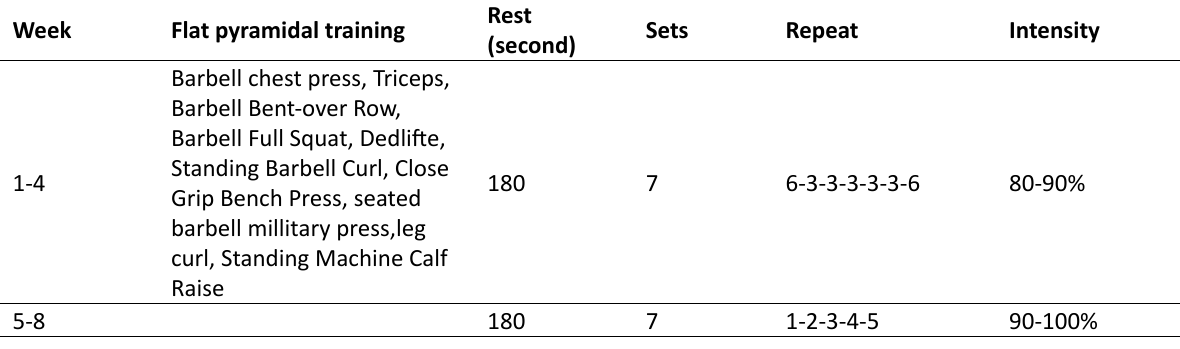
Table 2. Double pyramidal training